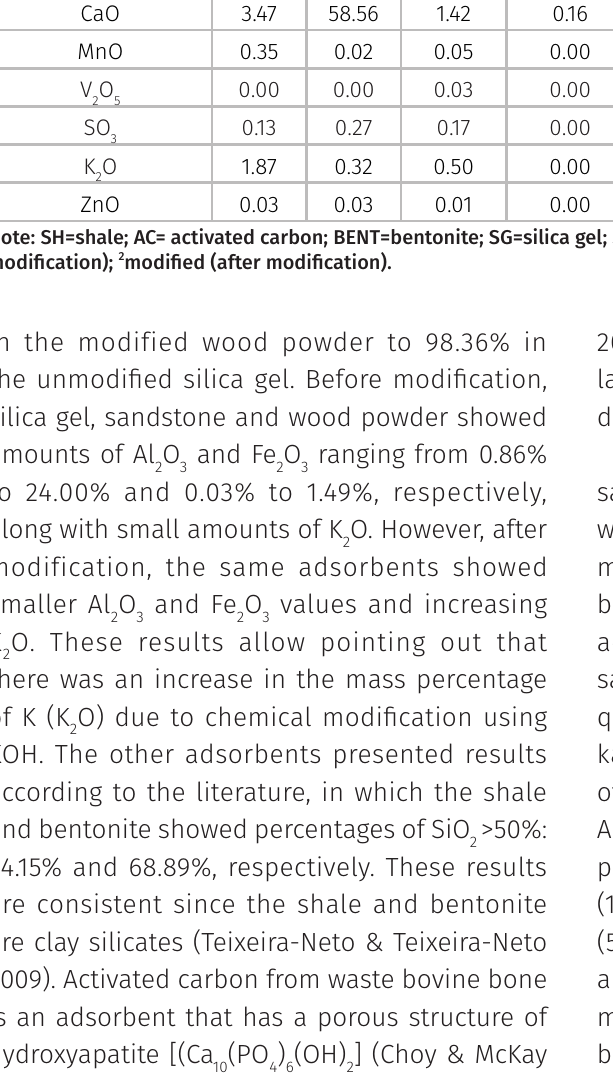
Chemical Composition (wt%)